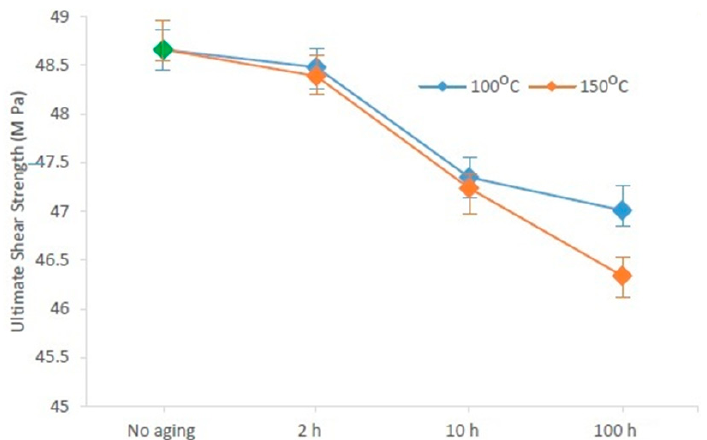
Figure 12. Comparison of USS thermally aged at 100 and 150 °C.